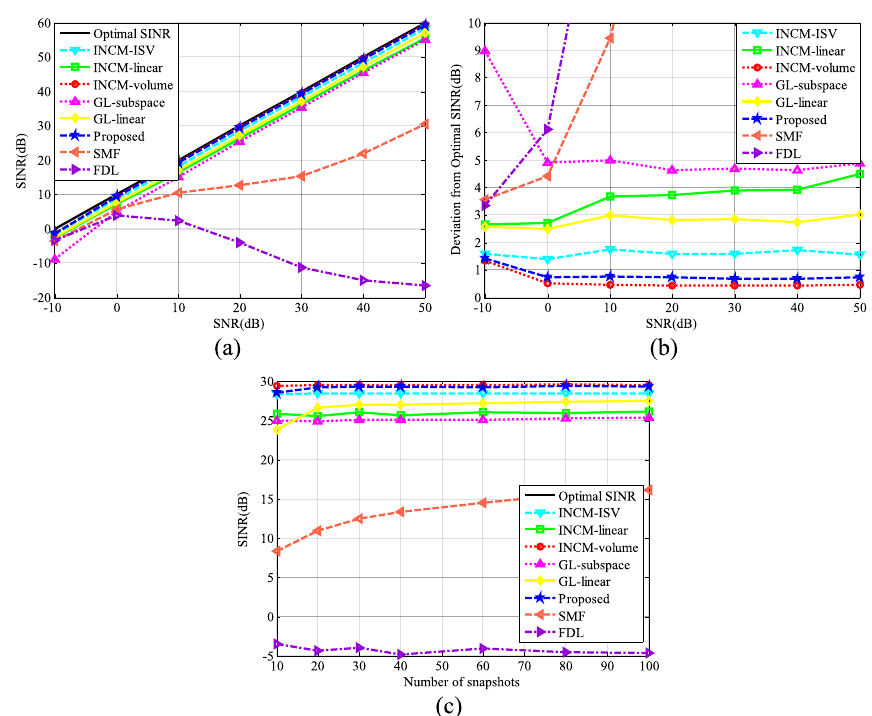
Fig. 6 Results of different interference powers. a SINR against SNR. b Deviation versus SNR. c SINR against number of